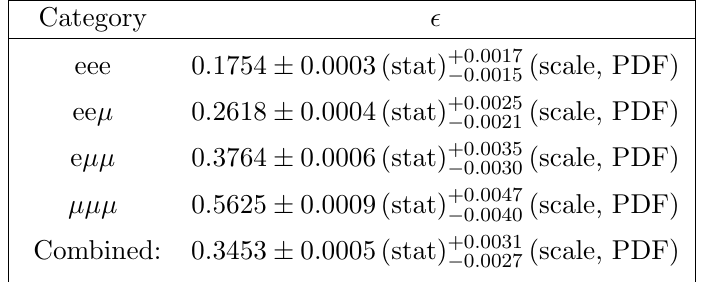
Table 4 . E(cid:14)ciencies estimated as transfer factors from the (cid:12)ducial region to the signal region using generator-level information, for an integrated luminosity L of 35 : 9 fb (cid:0) 1 . Statistical, scale, and PDF uncertainties are later propagated to the (cid:12)nal cross section measurement.